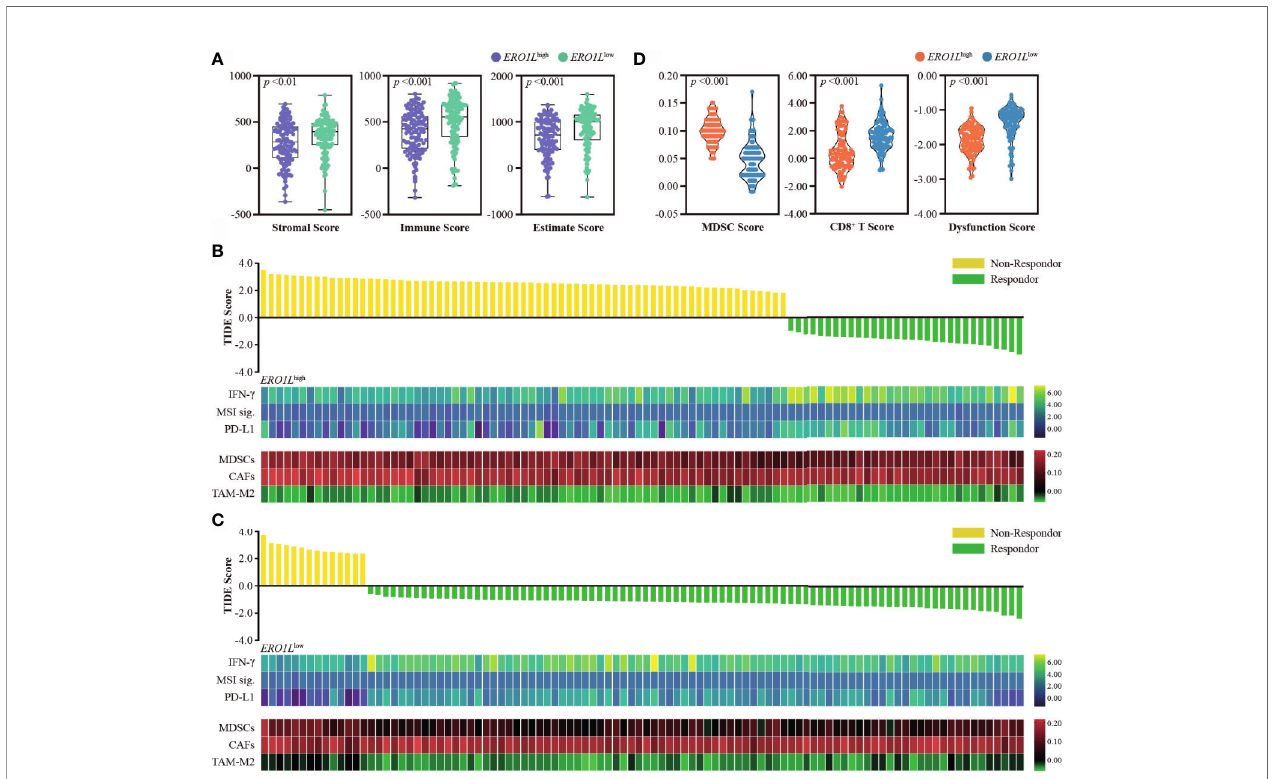
FIGURE 5 | Overexpression of ERO1L predicts resistance to immunotherapy. (A) Boxplot showing stromal, immune, and Estimate scores within ERO1L high and ERO1L low groups. (B, C) Prediction of immunotherapy response using the TIDE computational framework. Other biomarkers for immunotherapy were also assessed. These included: IFN- g , MSI signatures, PD-L1, MDSCs, CAFs, and TAM-M2. (D) Violin plot showing MDSCs, CD8 + T, and dysfunction scores within the ERO1L high and ERO1L low groups. Groups are labeled in different colors according to their level of ERO1L